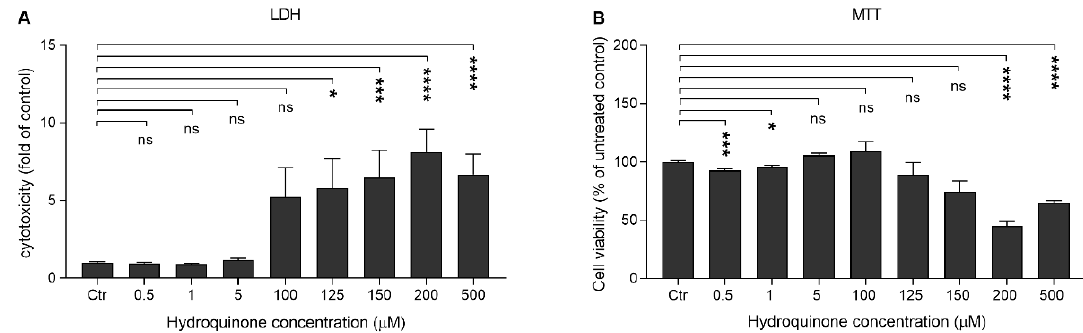
Figure 1. Cell viability of ARPE-19 cells upon hydroquinone exposure. The viability of untreated control cells (Ctr) was set to be 1 in case of lactate dehydrogenase (LDH) ( A ) and 100% in 3-(4,5-dimethylthiazol-2-yl)-2,5-diphenyltetrazolium bromide (MTT) ( B ). Other groups were compared individually to untreated control cells. Results are combined from three independent experiments with 4 parallel samples per group in each experiment and shown as mean ± SEM. * p < 0.05, *** p < 0.001, **** p < 0.0001, ns—not significant, Mann-Whitney U-test.